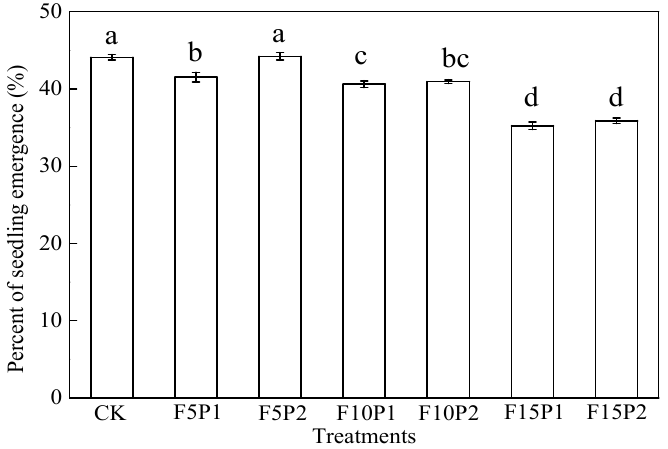
Figure 2. Percent of seedling emergence of Artemisia ordosica in CSL. Note: Letters indicate significant differences.